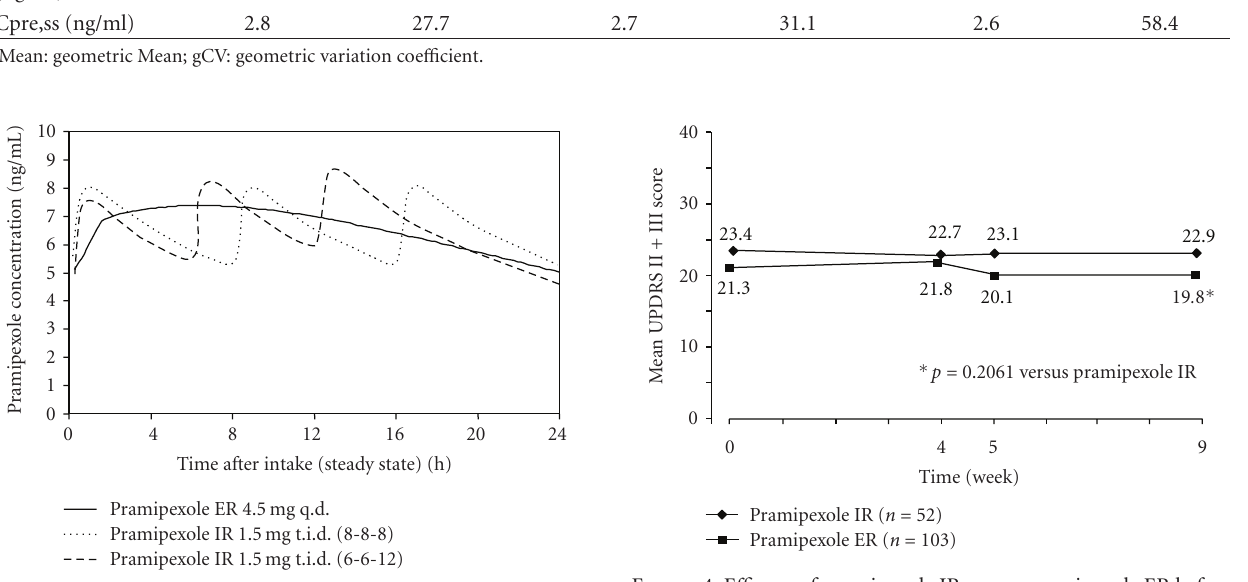
Figure 3: simulated concentration time profile of pramipexole ER and pramipexole IR at steady state in Parkinson patients after intake of pramipexole ER 4.5 mg q.d. or pramipexole t.i.d.) in intervals of